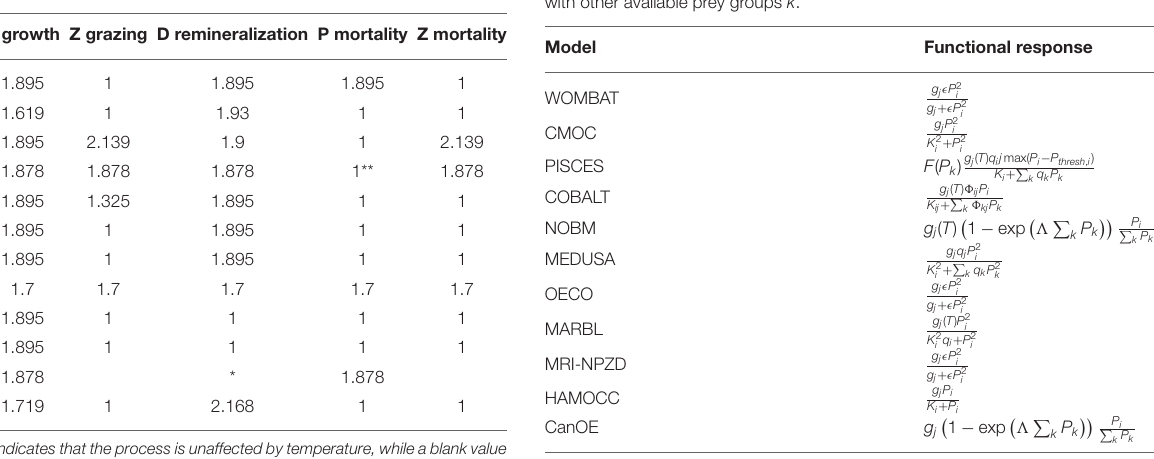
TABLE 5 | Q10 factor associated with various model processes for a given ESM.